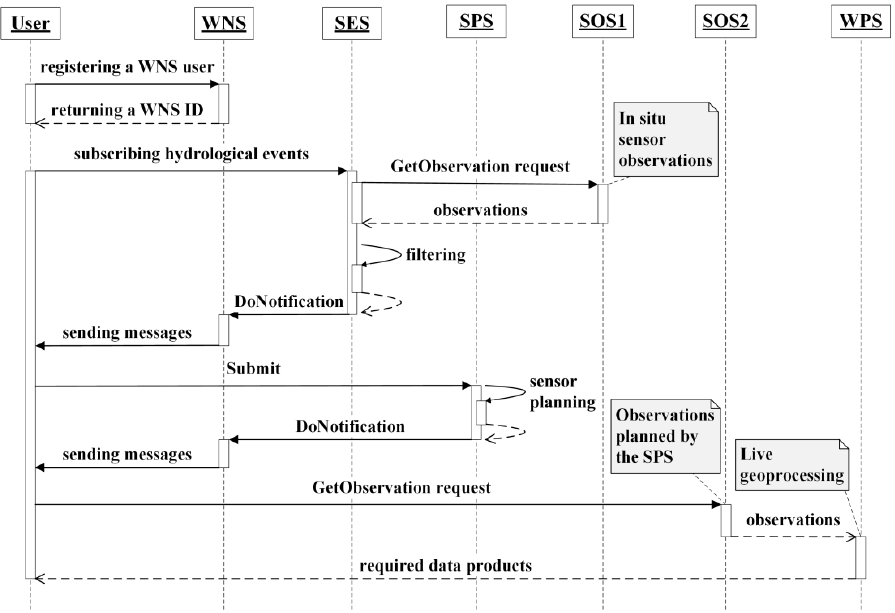
Figure 1. Using Sensor Web services for hydrological disaster monitoring. SOS1 makes in situ sensor